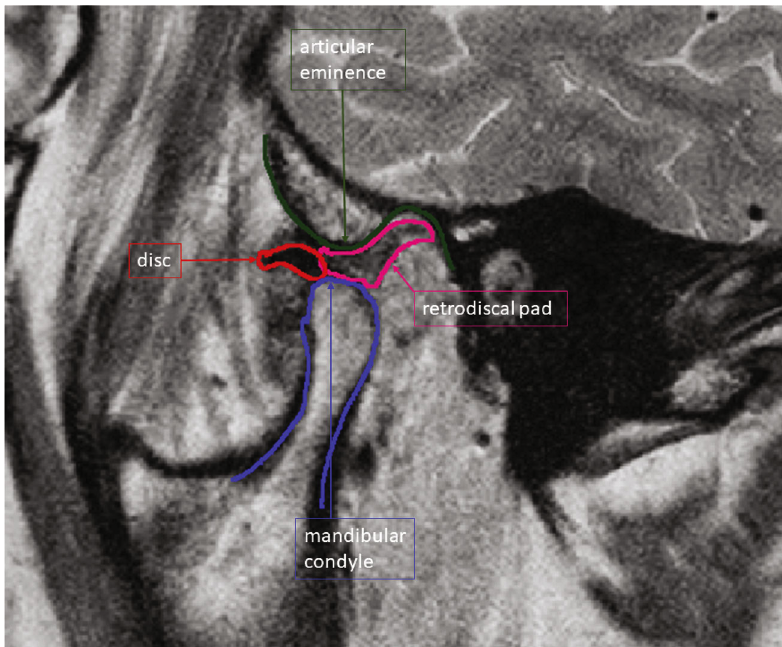
Figure 6: Dynamic MRI of the TMJ at 10-week follow-up with patient ’ s mouth in the open position revealed persistent left disk displacement, however, without signs of in fl ammation or e ff usion. The condyle moved further forward than in the fi rst MRI examination and reached the top of the articular